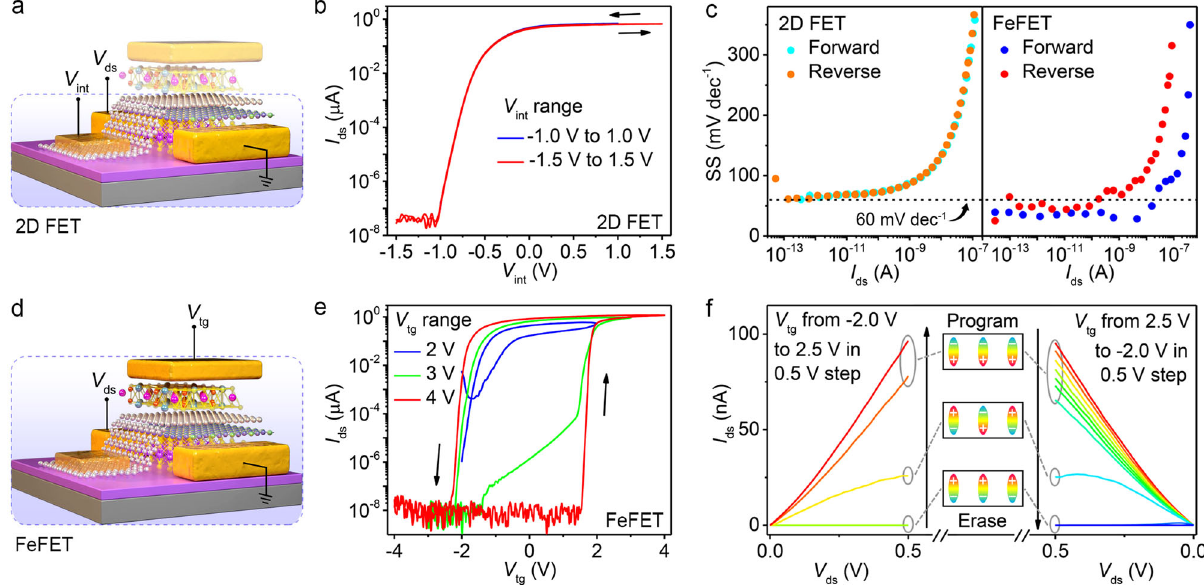
Fig. 2 Electric transport properties of vdW FeFETs. a Schematics of the measurement setup used to characterize the internal 2D FET. b Internal-gate I − V ds int characteristics of 2D FET at various gate voltage ranges measured with channel and an 87-nm-thick CIPS layer. c Internal-gate SS − I ds characteristics (left) and top-gate SS − I ds characteristics (right) for the forward and reverse sweep. d Schematics of the measurement setup used to characterize the vdW FeFET. e Top-gate I ds − V tg characteristics of the vdW FeFET at various gate voltage ranges measured with V ds = 0.5 V and internal gate fl oating. f The I ds − V ds curves for the forward and reverse V tg step direction with the internal gate fl oating.